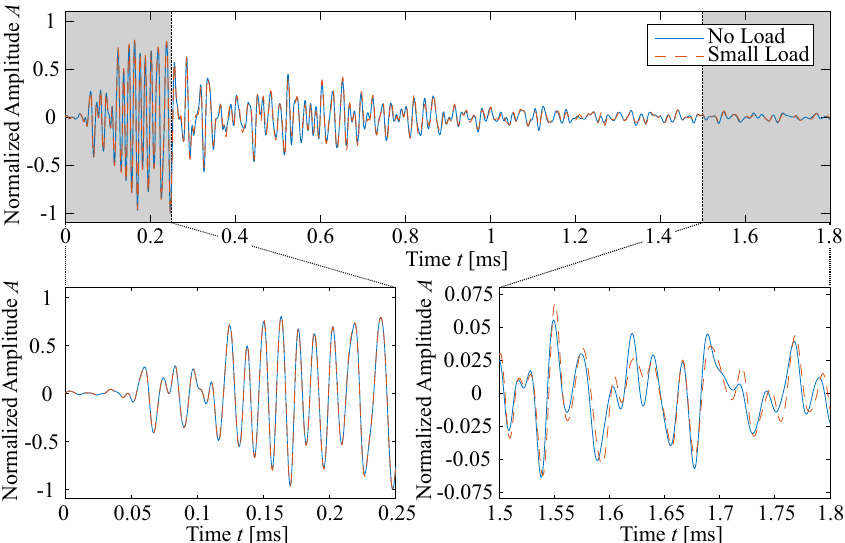
Figure 4. A comparison of measurements with embedded transducers in a concrete beam shows the small influence of subtle changes. While in the first arrivals (bottom left) no change is visible, small differences in the later coda part indicate a change in the specimen (bottom